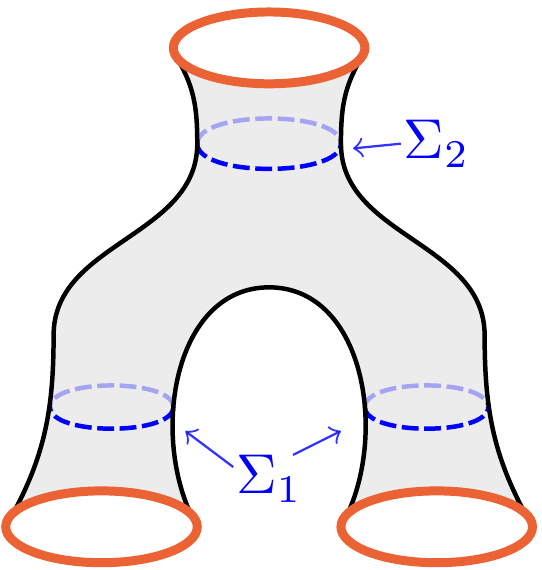
Figure 3 . In the presence of spacetime wormholes, di(cid:11)erent spatial slices of a spacetime may have di(cid:11)erent number of connected components. Here, on the slice (cid:6) 1 we have two circular universes, but on (cid:6) 2 we have only one. These may be thought of as di(cid:11)erent gauge choices for the same